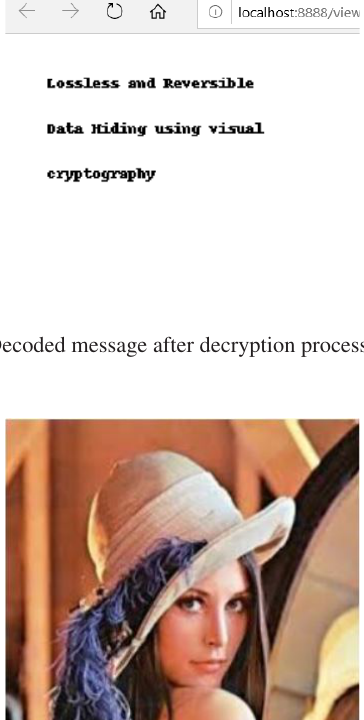
Figure 5. DECRYPTION PROCESS